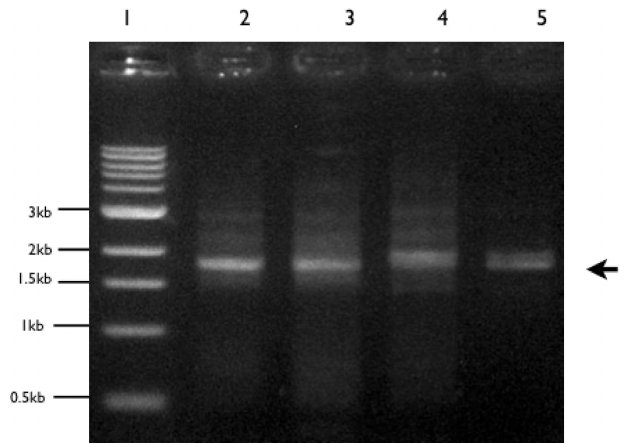
Figure 1. PCR products amplified from genomic DNA from field mudflat sample and laboratory developed cultures from Savannah River. Lane 1: 1 KB DNA Ladder; Lane 2: DNA template from field mudflat sample; Lane 3: DNA template from freshwater habitat (used for comparison); Lane 4: DNA template from agar culture; Lane 5: DNA template from liquid culture. Arrow indicates the genomic PCR